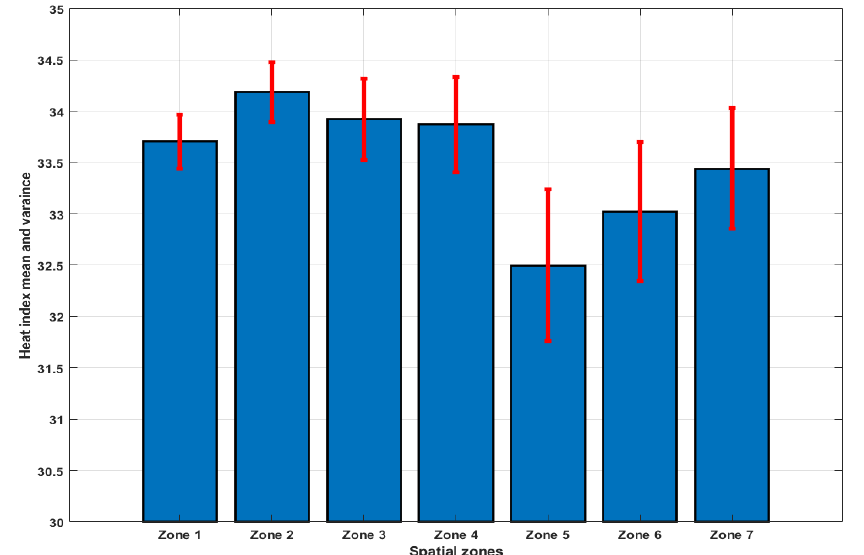
Figure 13. Mean and variance values of the seven allocation zones according to Theorem